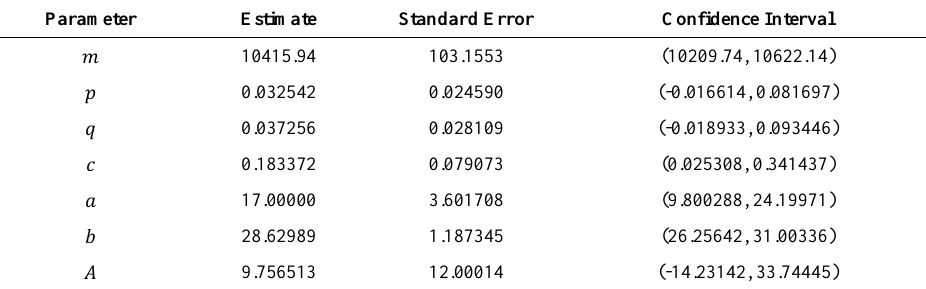
Table A21. Tuscany. Estimates, asymptotic standard errors and 95% mCIs for the parameters of the BeGBM 𝑹𝑬𝑪𝑻 (7)+(5).